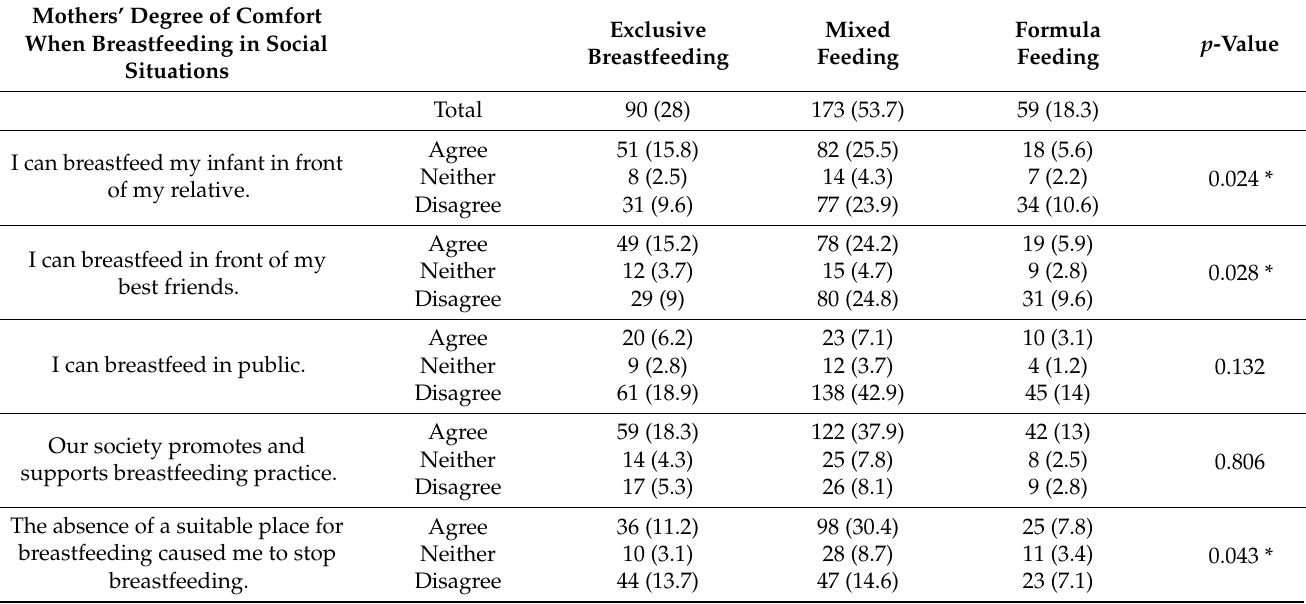
Table 3. Associations of Saudi mothers’ degree of comfort in breastfeeding in social situations with their infants’ actual feeding practices for the first six months of their infants’ lives in Riyadh, Saudi Arabia. Mothers’ Degree of